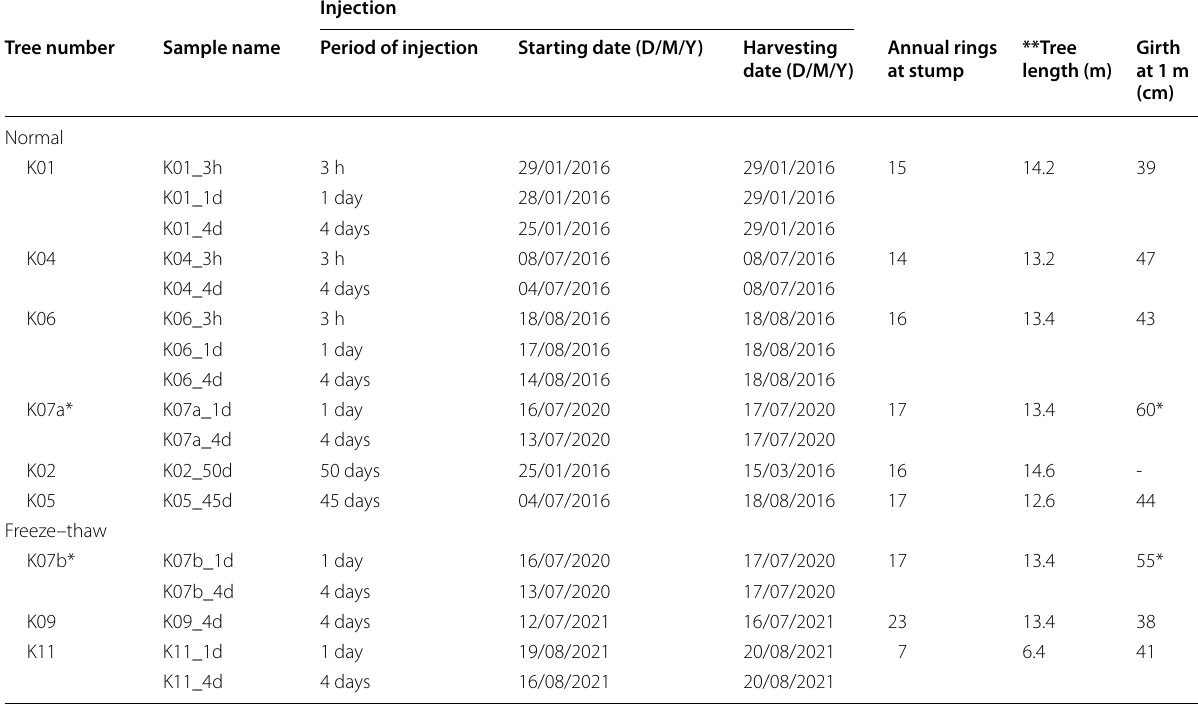
* Biforked trunks of the same tree. Girth was measured at approximately 2 m. **Length of the main stem measured after felling. -, no data